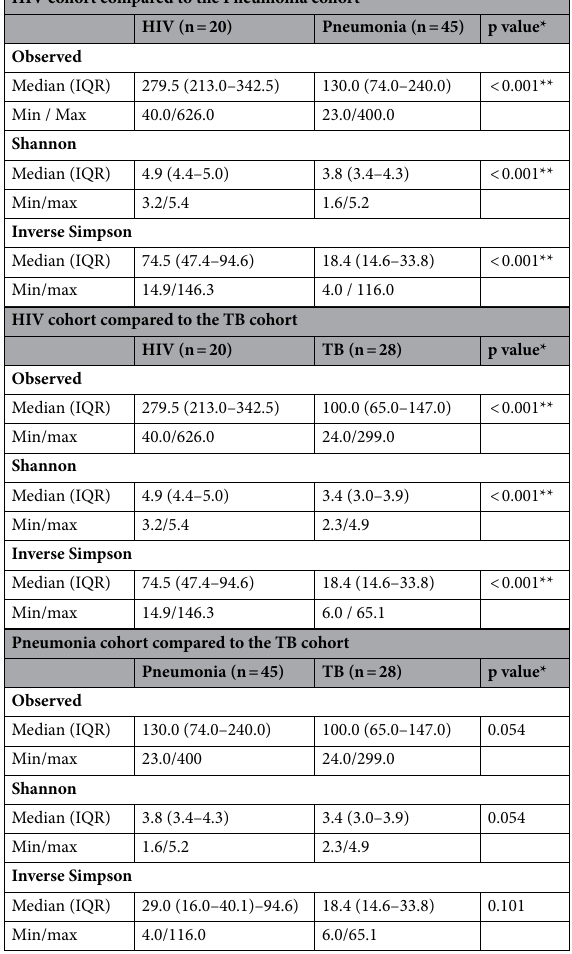
Table 2. Alpha diversity by the indices: Observed, Shannon and Inverse Simpson the between various cohorts. *Nonparametric Wilcoxon rank sum test. **Statistically